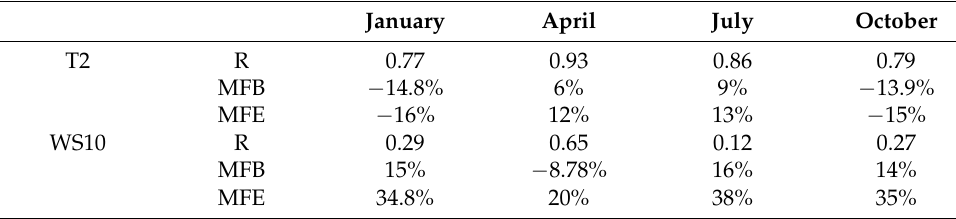
Table 1. Statistical indicators for WRF model evaluation in Bozhou in January, April, July, and October